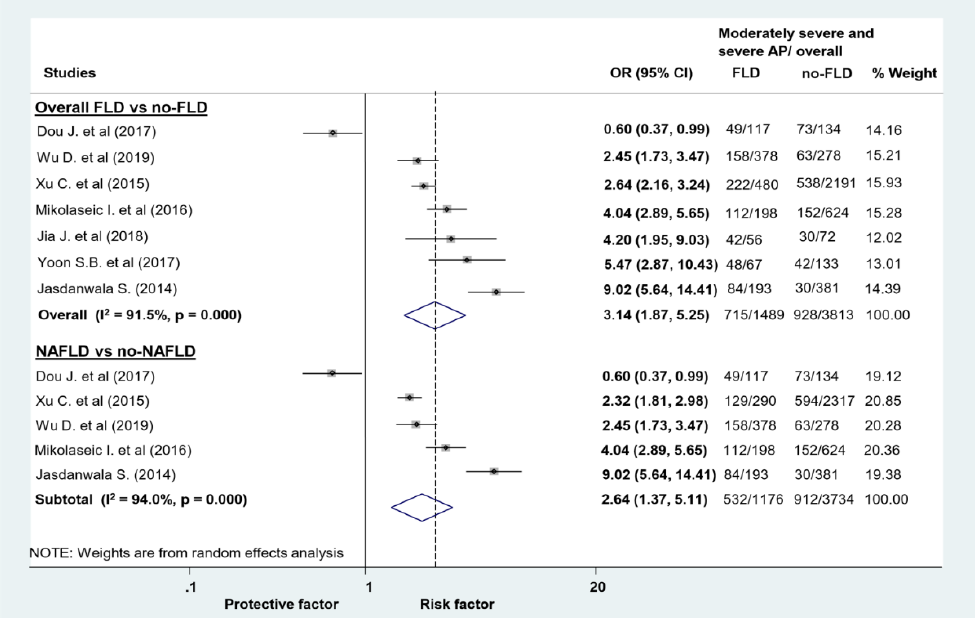
Figure 3. Forest plots of studies evaluating the association between fatty liver disease (FLD) or non-alcoholic fatty liver disease (NAFLD) and disease severity of acute pancreatitis (AP). We compared the odds of moderately severe/severe vs mild AP in patients with and without FLD/NAFLD; CI: confidence interval, OR: odds ratio.